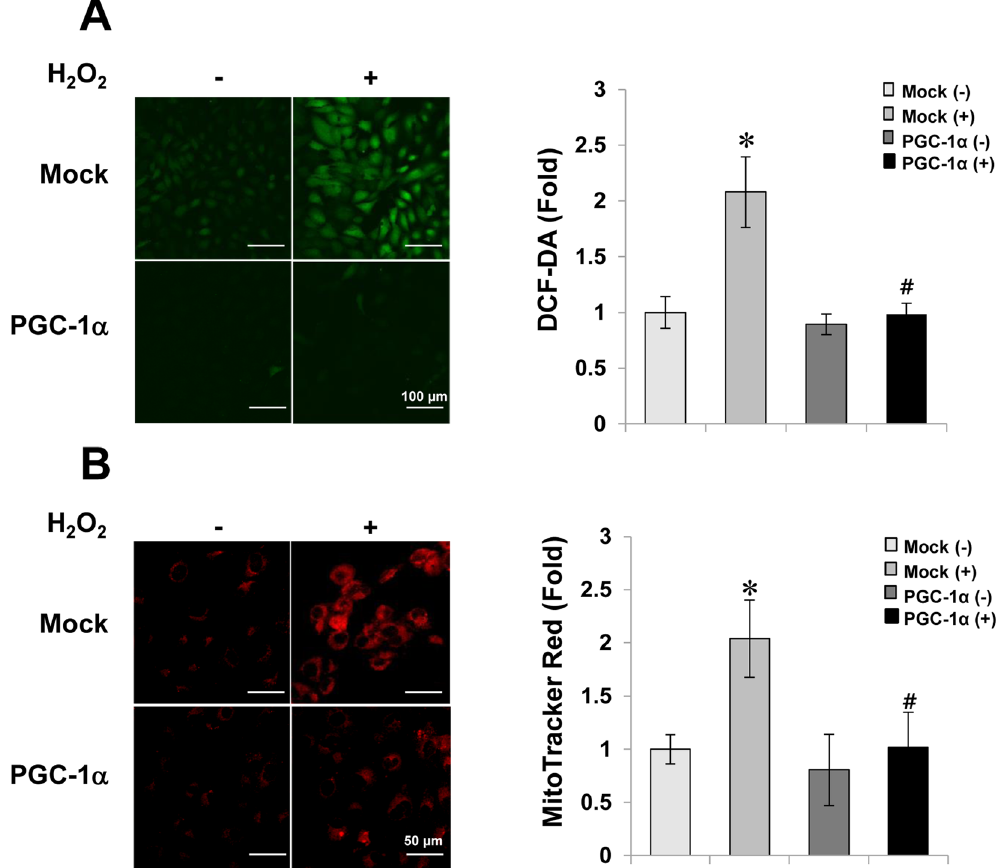
Figure 5. Reduction of intracellular ROS by PGC-1 α . To check the efficiency of PGC-1 α overexpression in reducing ROS, stable cells were plated onto four well-cell culture slides (5 × 10 4 /well) and treated with 0.5 mM H 2 O 2 for 30 min. Cytosolic (magnification at x200, Bar = 100 μ m) ( A ) and mitochondrial ROS (magnification at x400, Bar = 50 μ m) ( B ) were labeled using CM-H 2 DCFDA or CM-H 2 XROS probes, respectively. Images were immediately visualized using confocal microscopy on a laser scanning microscope (LSM 510; Carl Zeiss), and analyzed using a LMS 5 browser imaging software. Error bars denote the mean ± S.D. of triplicate samples. * p < 0.05 H 2 O 2 -untreated vs. H 2 O 2 -treated in Mock; # p < 0.05; H 2 O 2 -treated Mock vs. PGC-1 α